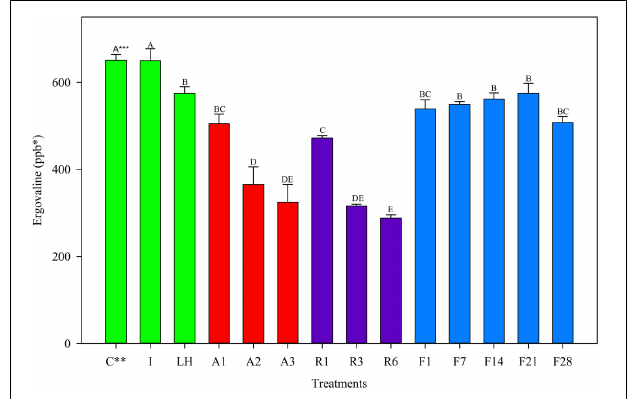
FIGURE 1 | Ergovaline concentration of all tall fescue sub-samples in various storage conditions from May 2012 harvest. ∗ Parts per billion. ∗∗ Treatment abbreviations are as follows: C, Control; I, Ice; LH, Light + Heat; A1, Ambient Day 1; A2, Ambient Day 2; A3, Ambient Day 3; R1, Refrigerator Day 1; R3, Refrigerator Day 3; R6, Refrigerator Day 6; F1, Freezer Day 1; F7, Freezer Day 7; F14, Freezer Day 14; F21, Freezer Day 21; and F28, Freezer Day 28. ∗∗∗ Matching letters indicate no statistical difference at a significance level of P < 0 .